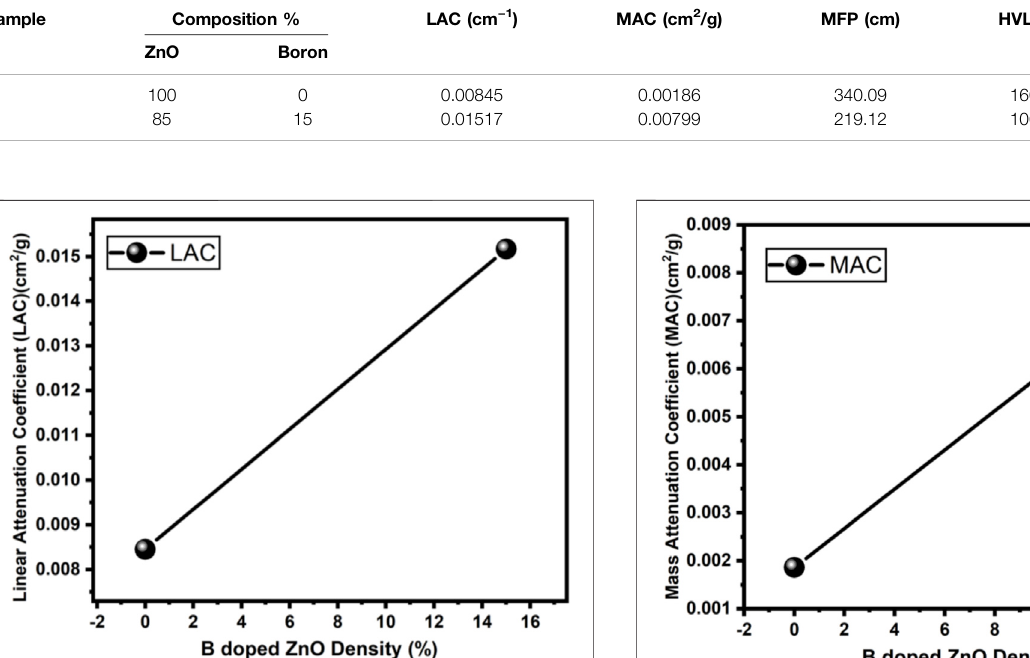
TABLE 3 | Various parameters (LAC, MAC, MFP, HVL, TVL) to analyze the radiation shielding ef fi ciency of B doped ZnO. Sample